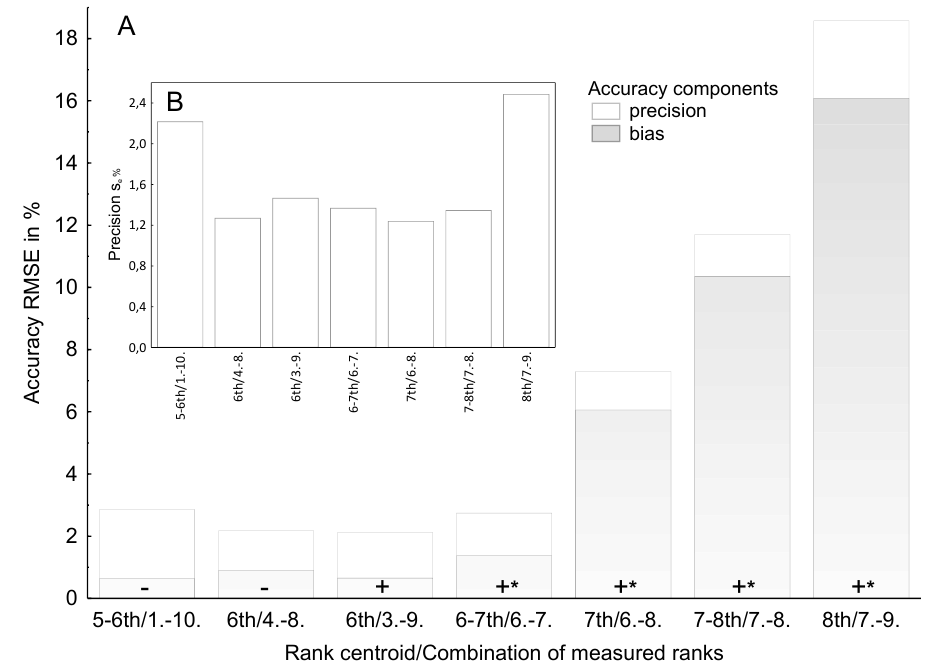
Figure 2. Comparison of accuracy ( A ); and precision ( B ) for two-measurement modifications of Weise’s rule averaged across all stands. The stacked accuracy bars representing averaged proportions of bias ( grey ) and precision ( white ) on accuracy were calculated as ratios of squared bias/precision on squared RMSE. Signs in bias proportion parts show the prevalent direction of original biases (under- or overestimation), and the signs denoted by an asterisk indicate the prevalence of statistically significant biases at a p -value of